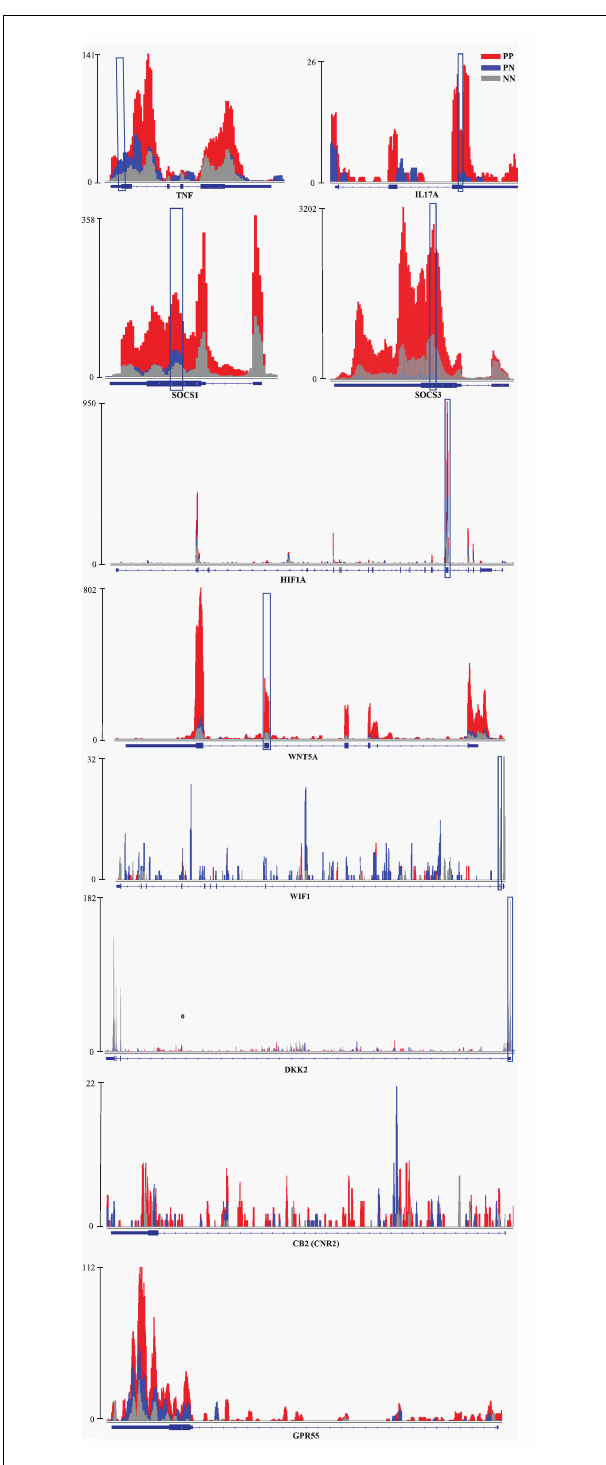
FIGURE 3 | Examples of genes with m 6 A peaks in PP, PN, and NN. Integrative Genomics Viewer (IGV) tracks showed MeRIP-seq reads distribution in TNF, IL-17A, SOCS1/3, HIF1A, WNT5A, WIF1, DKK2, CNR2, and GPR55 mRNA of PP, PN, and NN. Different colors illustrate the accumulation of m 6 A-IP reads. The blue squares indicate the verified sequence